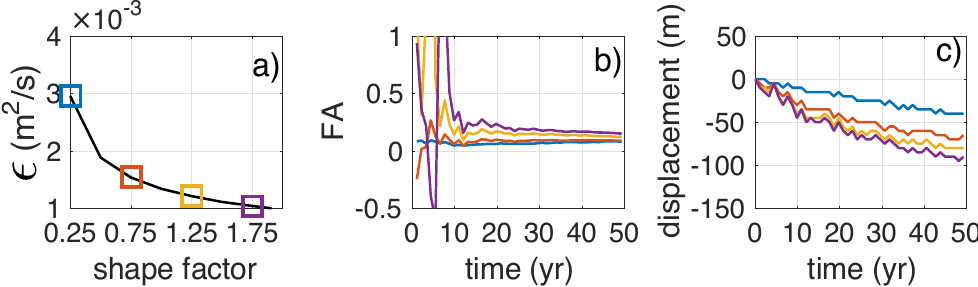
Figure 9. Effect of the initial mega-nourishment shape factor on: ( a ) the final five-year diffusivity, as well as on the 50-year evolution of ( b ) the FA and ( c ) the